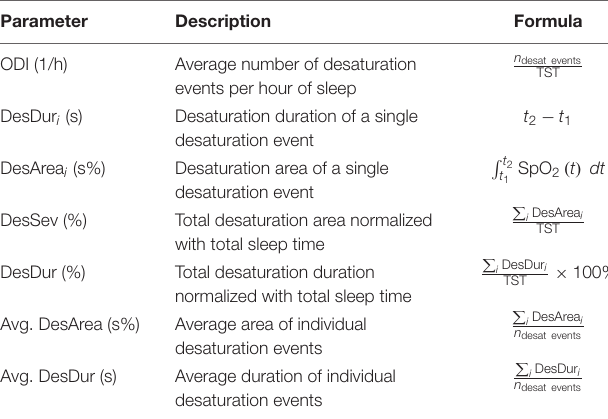
TABLE 1 | Descriptions and formulas of desaturation